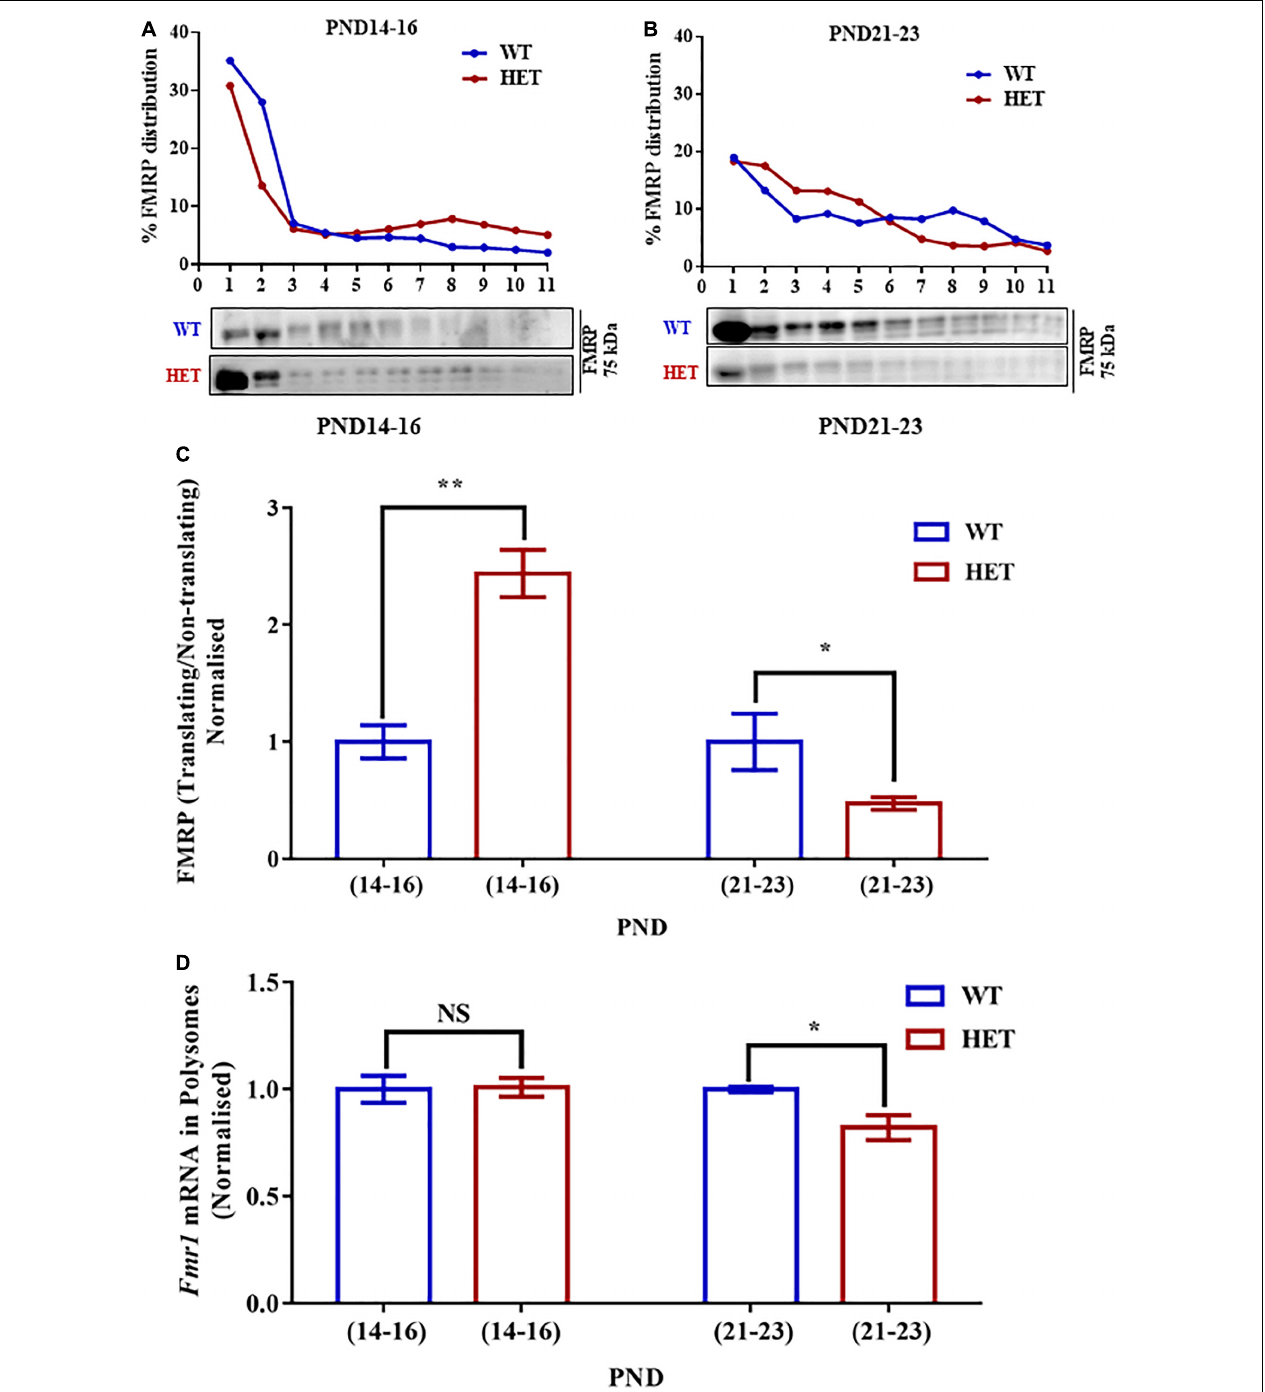
FIGURE 4 | Decreased Fmr1 mRNA and FMRP distribution in translating fractions of polysomes in HET during PND21-23. (A) Representative line graphs showing percentage FMRP distribution in polysomes during PND14-16 ( top ) along with representative immunoblot for FMRP distribution ( below ). (B) Line graph showing representative percentage FMRP distribution in polysomes during PND21-23 ( top ) and the corresponding representative immunoblot for FMRP distribution ( below ). (C) Bar graph showing FMRP distribution in translating/non-translating fractions in HET normalized to WT during PND14-16 (WT: N = 4; HET: N = 4) and PND21-23 (WT: N = 4; HET: N = 5). ∗ p < 0.05 and ∗∗ p < 0.01; Unpaired Student’s t -test. (D) Bar graph depicting relative Fmr1 mRNA in translating fractions of HET normalized to WT during PND14-16 (WT: N = 3; HET: N = 3) and PND21-23 (WT: N = 3; HET: N = 5). ∗ p < 0.05, NS, not significant; Unpaired Student’s t